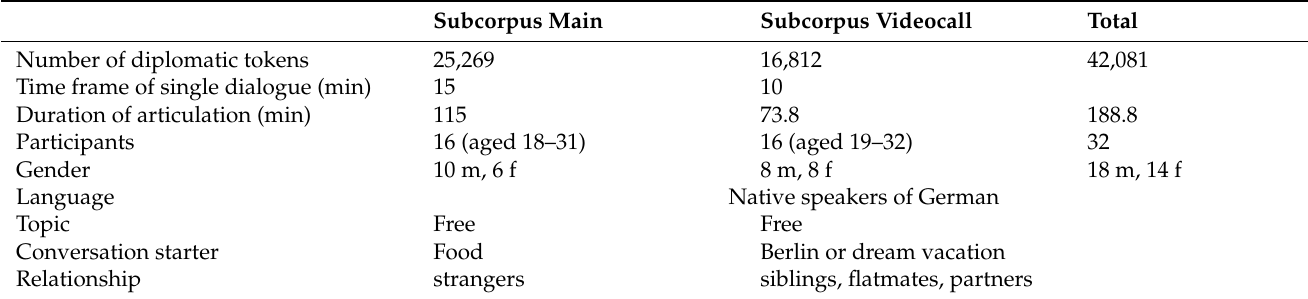
Table 1. Corpus summary of